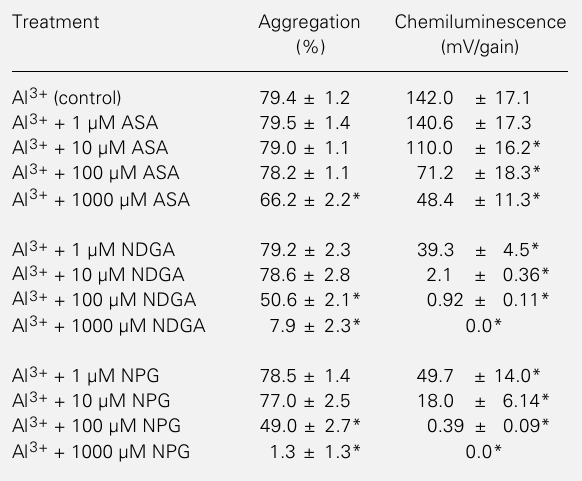
Table 3 - Effects of acetyl salicylic acid (ASA), nor-dihydroguaiaretic acid (NDGA), and n -propyl gallate (NPG) on human platelet aggrega- tion and chemiluminescence stimulated with 100 (cid:181)M Al 3+ . Platelets were preincubated with NDGA, NPG or ASA for 5 min at 37 o C before stimulation. Each value represents the mean – SEM of 10 independent experiments. *P<0.05 compared to control (Student t -test).